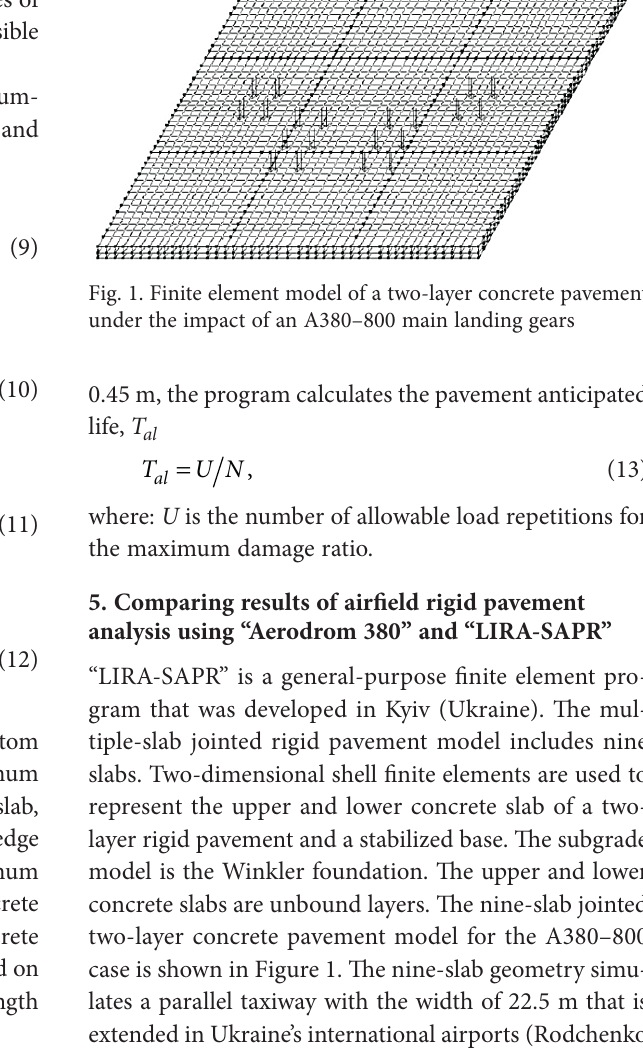
Table 2. Comparative results of the “LIRA-SAPR” and “Aerodrom 380” analysis The maximum tensile stress at the top and bottom of the upper slab Subgrade ratio (“LIRA-SAPR”), MPa МN/m 3 Top Bottom Top